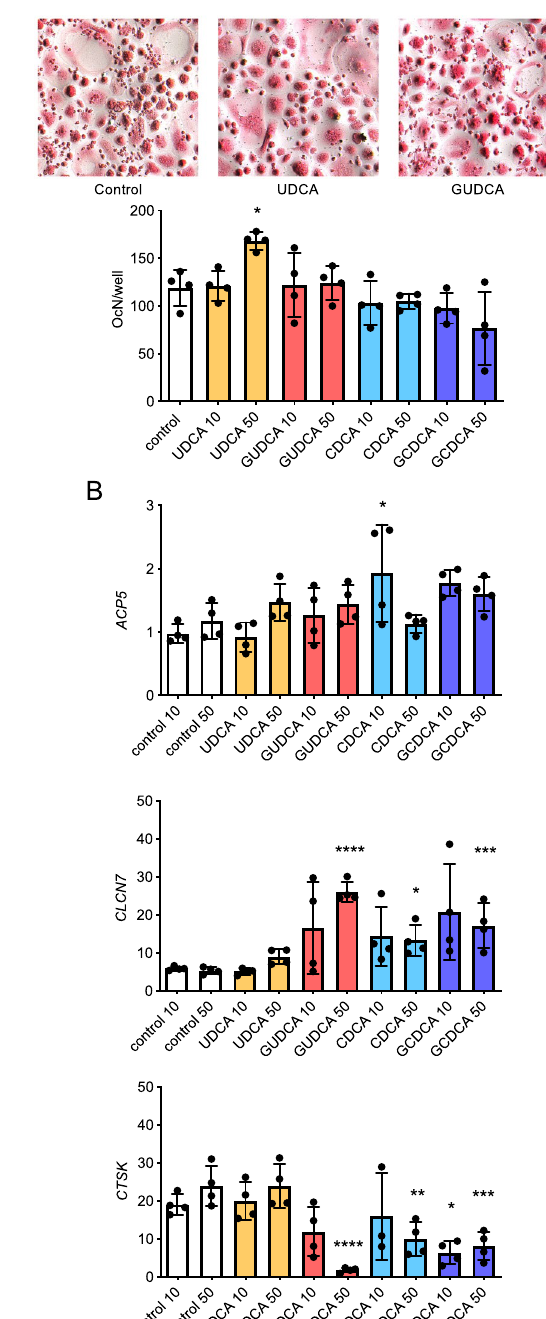
Figure 4. Influence of bile acids on osteoclastogenesis of peripheral blood mononuclear cells. ( A ) Representative images after TRAP activity staining of peripheral blood mononuclear cells differentiated for 14 days in the presence of M-CSF and RANKL. Quantification of multinucleated osteoclasts generated in the absence or presence of the indicated bile acids, at concentrations of 10 µM or 50 µM, is shown below. ( B ) qRT- PCR expression analysis of the osteoclast markers ACP5 , CLCN7 , and CTSK after 14 days of differentiation. * p < 0.05, ** p < 0.01, *** p < 0.001, **** p <